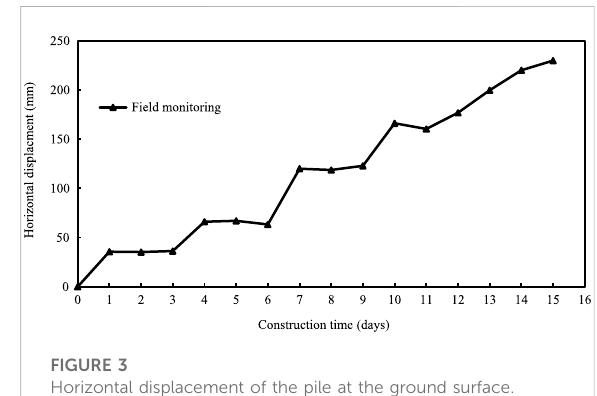
FIGURE 2 Construction consequence of the embankment fi ll.